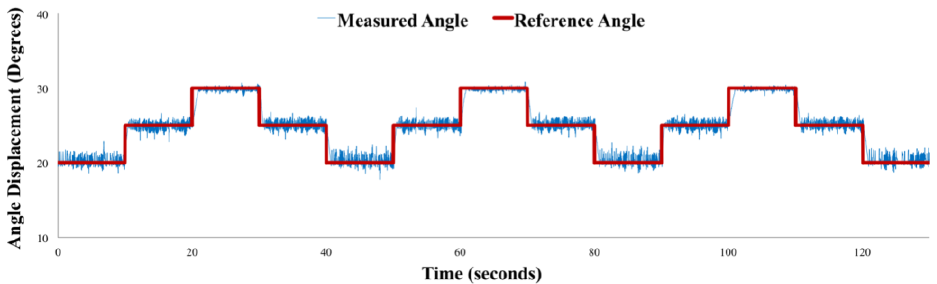
Figure 10. State transition map for the position control algorithm.